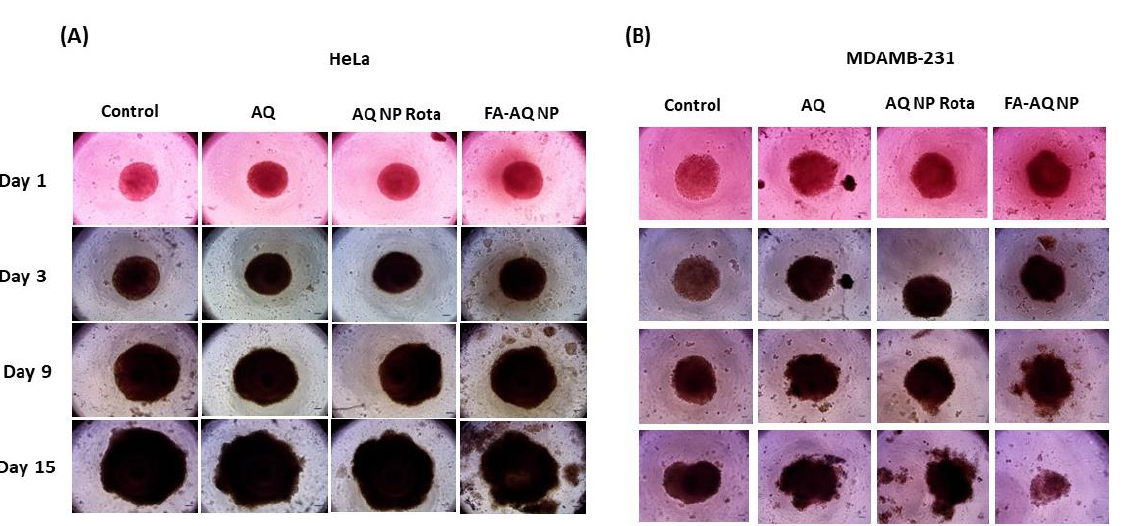
MDAMB-231: Figure 8B), and calculated spheroid volume comparisons (Figure 9A,B) are presented. For both the HeLa and MDAMB-231 cell lines, control spheroids were found to be growing in size/volume over 15 days, whereas the growth of nanoparticle-treated spheroids was significantly inhibited (Figure 8A,B).